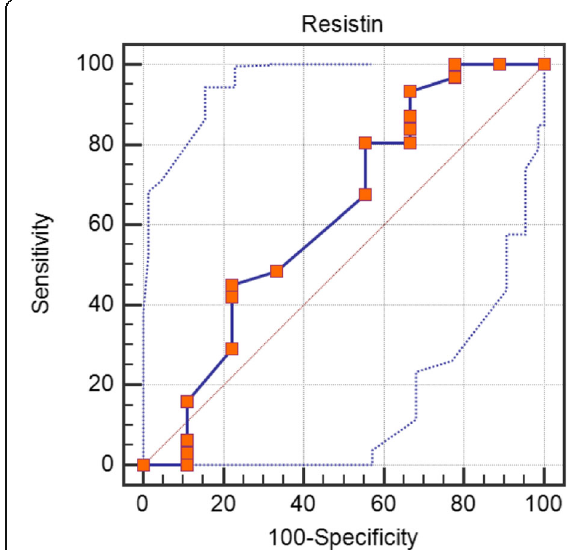
Fig. 2 ROC Curve of serum resistin level in prediction of significant insulin resistance in both studied groups of patients